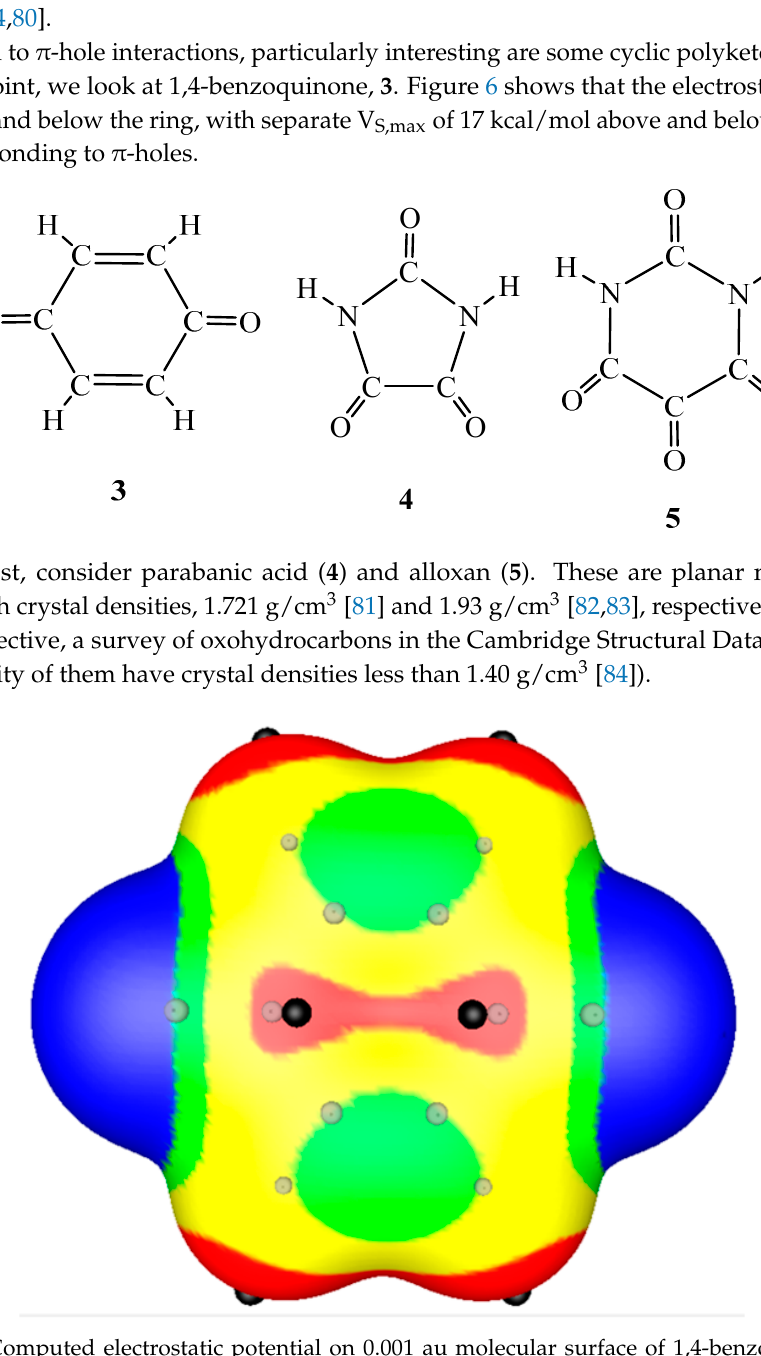
Figure 6. Computed electrostatic potential on 0.001 au molecular surface of 1,4-benzoquinone, 3 , which is planar. The oxygens are at the left and right. Gray circles indicate positions of nuclei. Black hemispheres correspond to V S,max due to π -holes above and below carbonyl carbons and σ -holes on hydrogens on extensions of C–H bonds. Color ranges, in kcal/mol: red, more positive than 14; yellow, between 14 and 7; green, between 7 and 0; blue, negative.